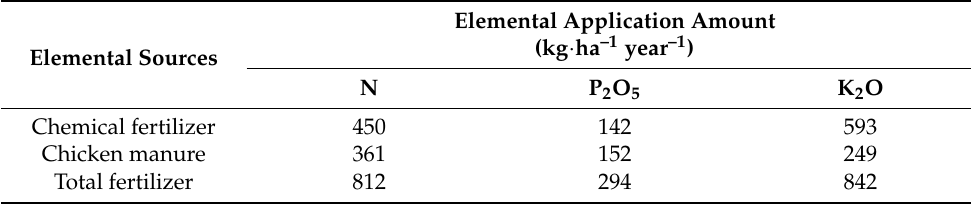
Table 2. Fertilizers and manure applied to the greenhouse cucumber cropping